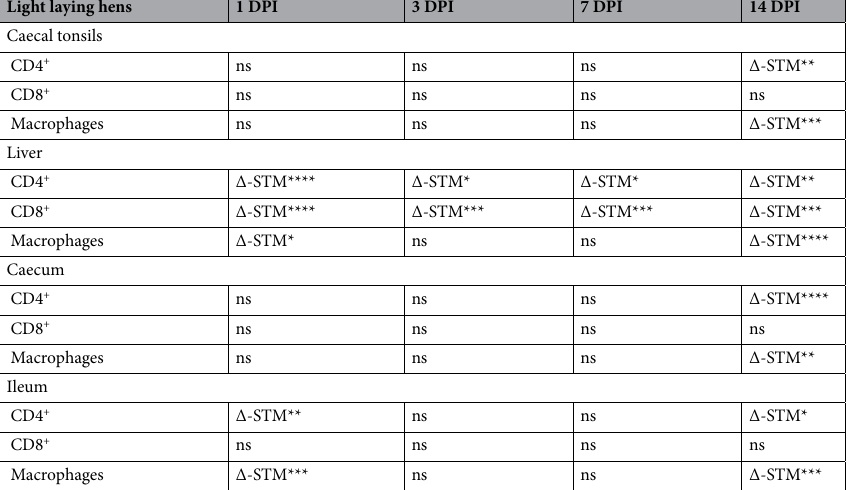
Table 6. Representation of the significant difference related to the quantitative distribution of different immune response cells in organs of light laying hens infected with Salmonella Typhimurium wild and mutant strains at different days post-infection. DPI, days post-infection; ∆-STM, Salmonella Typhimurium ∆ ttr A∆ pdu A; wt-STM, Salmonella Typhimurium wild-type; ns, no significant difference. Within each organ and DPI, * means difference by two-way ANOVA followed by Bonferroni’s comparison test between wild and mutant strains values (*P ≤ 0.05; **P ≤ 0.01; ***P ≤ 0.001; ****P ≤ 0.0001). The strain presented in the table (∆-STM or wt-STM) as significant within the organ and DPI is that shown the major infiltration area to each